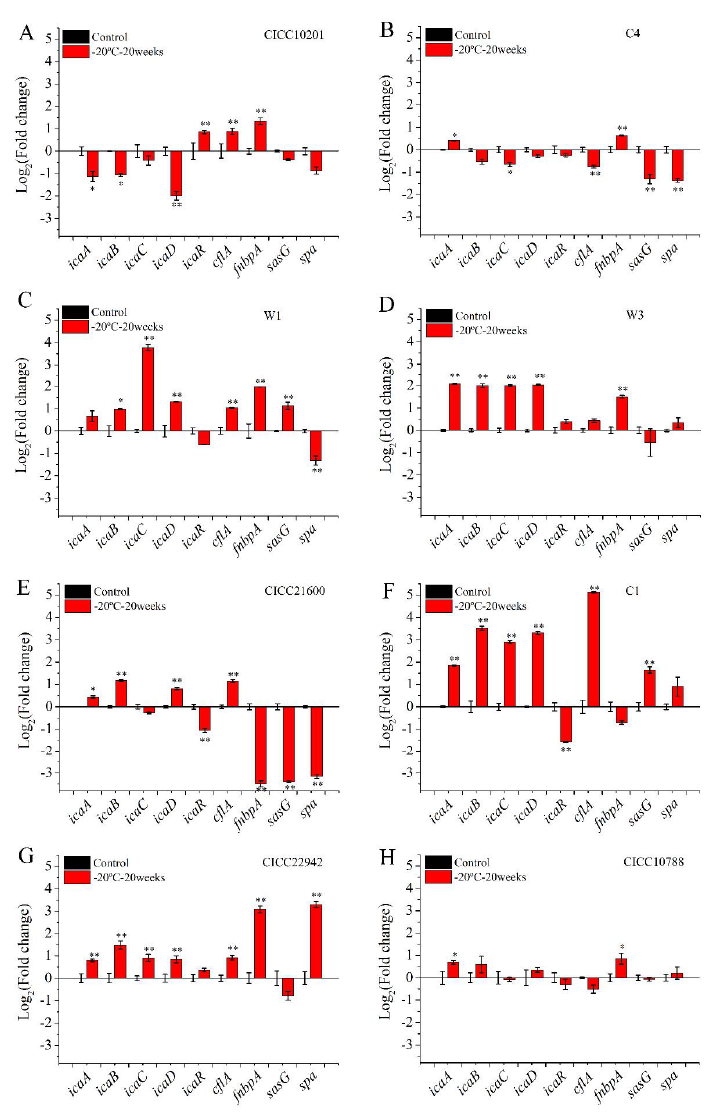
Figure 3. The transcription levels of genes in S. aureus biofilm cells with cold stress. Note: The transcription levels of genes in biofilm cells of S. aureus CICC 10201 ( A ), S. aureus C4 ( B ), S. aureus W1 ( C ), S. aureus W3 ( D ), S. aureus CICC 21600 ( E ), S. aureus C1 ( F ), S. aureus CICC 22942( G ), S. aureus CICC 10788 ( H ) was measured by Real-Time PCR. S. aureus without cold stress was used as the control group. The gene transcription levels in biofilm cells of S. aureus after cold stress for 20 weeks at − 20 ◦ C were tested. The polysaccharide intercellular adhesin (PIA) is mainly regulated by icaABCDR gene. The adhesion proteins included sasG , cflA , spa , or fnbpA genes. **: Compared with the control group, the tested sample was significantly different ( p < 0.01), *: Compared with the control group, the treated sample was different ( p < 0.05). The values were means ± SD ( n =